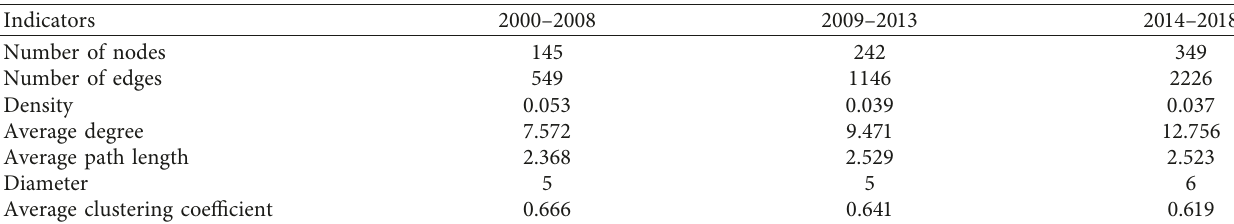
Figure 2: Three stages of international cooperation network evolution of Chinese business school from 2000–2018. (a) 2000–2008. (b) 2009–2013. (c) 2014–2018. Table 5: Changes of network indicators in three